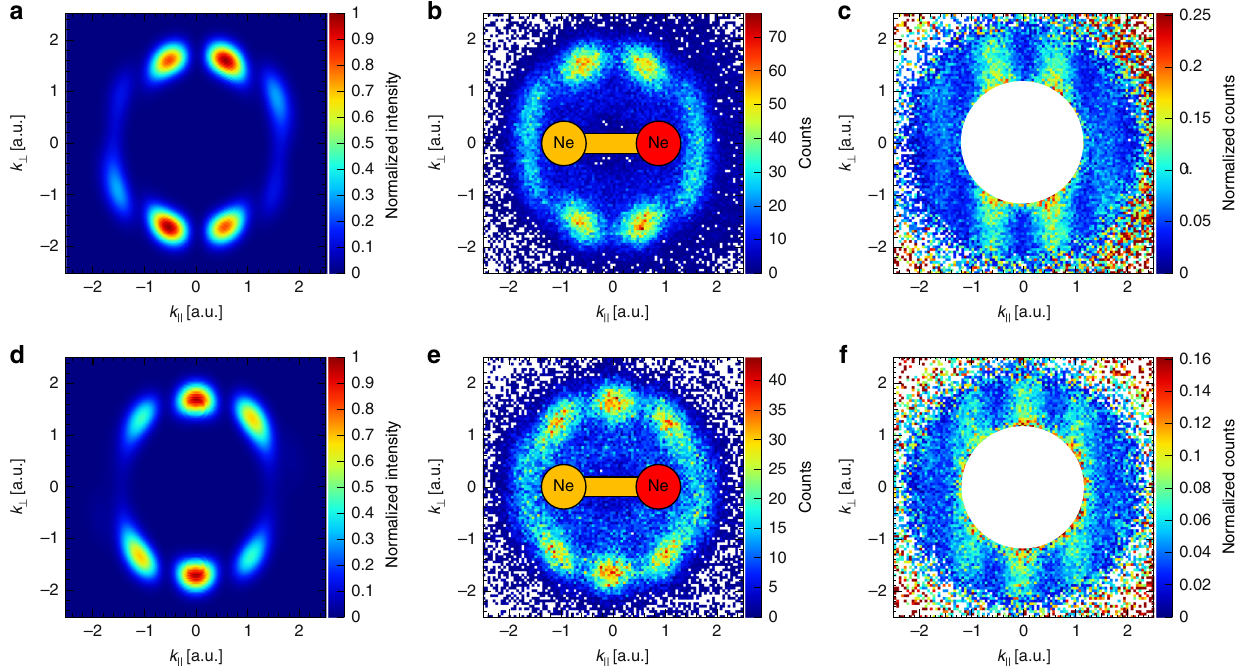
Fig. 2 Photoelectron momentum distributions of Ne 2 in the molecular frame for the circularly polarized light. a , d are simulated spectra with two coherently superimposed atomic distributions; b , e – measured for the direct and indirect dissociations, respectively; c , f are the same as the distributions in b , e but normalized to the monomer distribution in order to remove ionization weighting of the fi nal momenta. The red side of the sketched molecule de fi nes the momentum direction of the measured neon ion. k ║ and k ⊥ are the electron momentum components parallel and perpendicular to the dimer axis, respectively (Fig. 2e, indirect dissociation). This swapped interference beha- Normalization of the electron spectra of the dimer by the vior is understood given the p -character of the orbitals. The single-ionization spectrum of neon atoms, which is recorded in interference is indeed seen in the fi nal electron momentum, the same measurement, allows us to remove the intrinsic which is acquired in a laser fi eld after ionization rather than in the ionization weighting, which has a doughnut-like shape due to initial momentum at the tunnel exit. tunneling ionization in a circular laser fi eld 35,36 . After such NATURE COMMUNICATIONS| (2019) 10:1